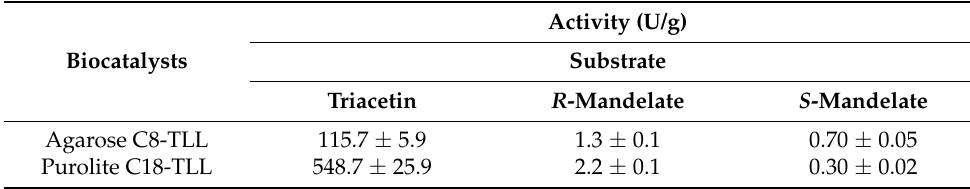
Table 1. Activity of the prepared biocatalysts in the hydrolysis of different substrates under the defined conditions. Experiments were conducted as described in Methods.